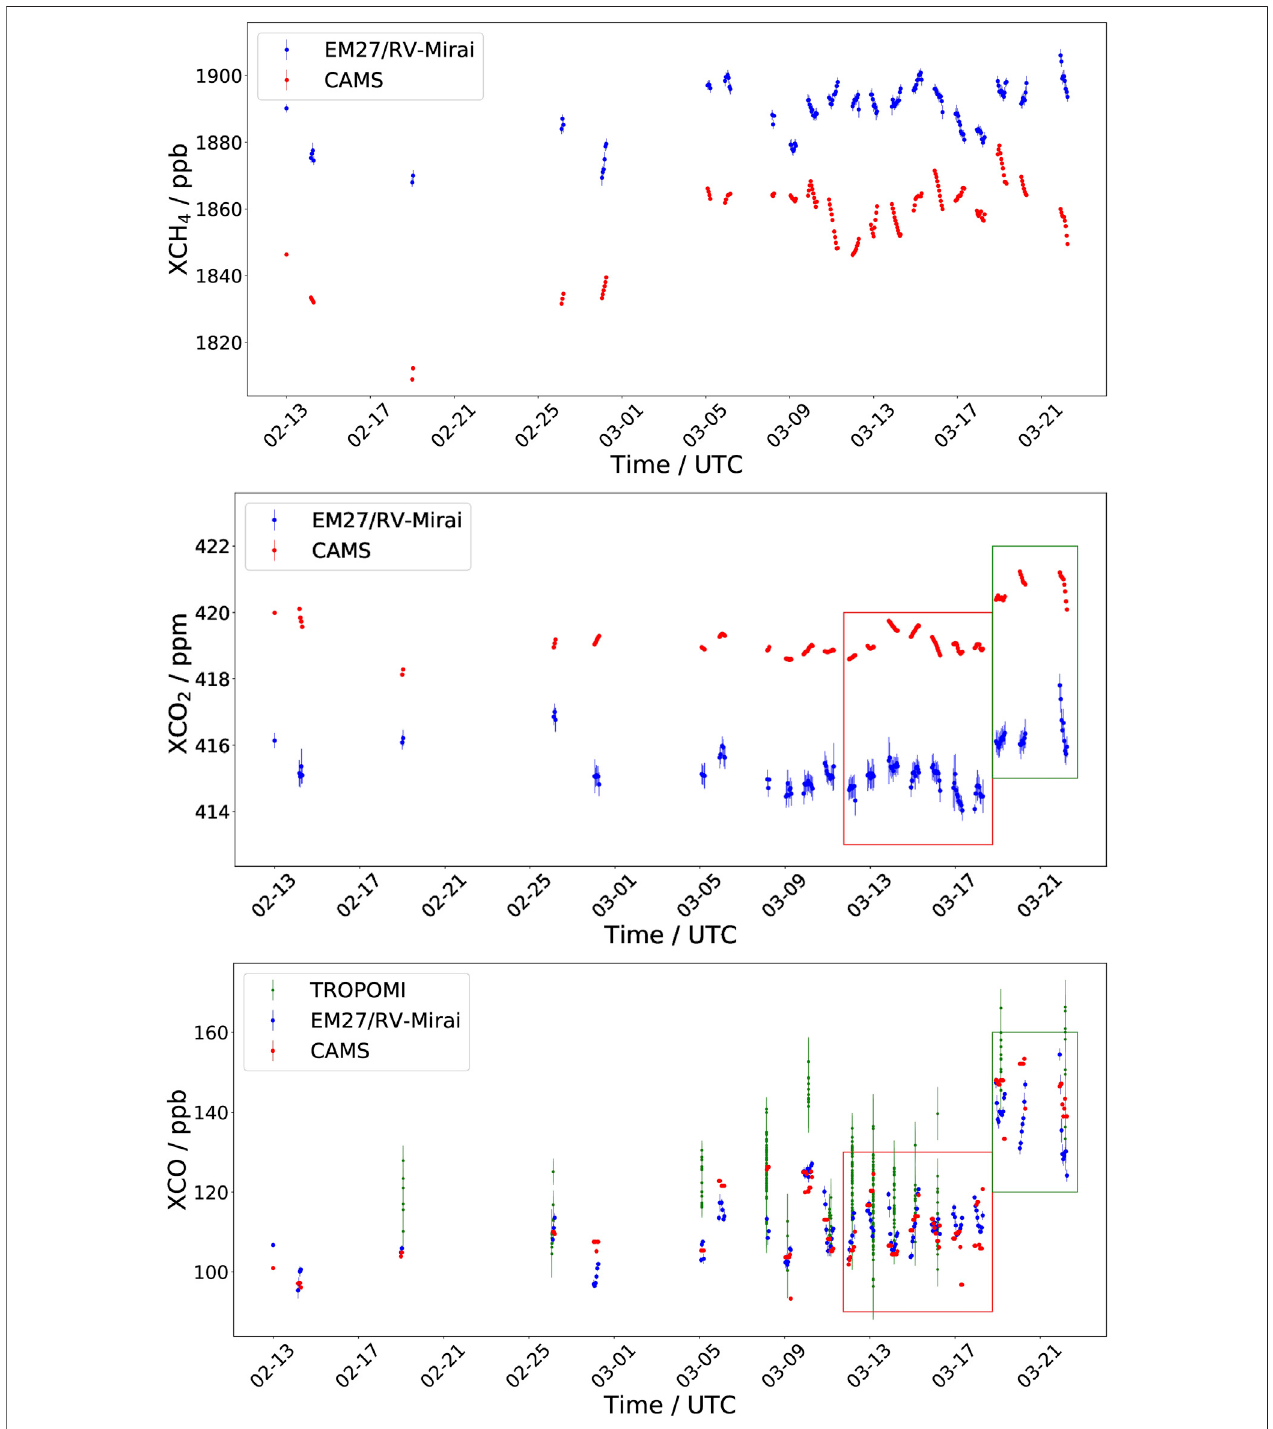
FIGURE4| TimeseriesofXCH 4 (upperpanel),XCO 2 (middlepanel),andXCO(lowerpanel)oftheEM27/SUNonRVMirai(blue),co-sampledCAMSdata(red),and co-incident TROPOMI XCO measurements (green). The EM27/SUN records our hourly averages with hourly standard deviations shown as error bars. For TROPOMI, individual XCO data are shown with their provided error-bars. The red and green boxes (upper and lower panel) de fi ne the background and enhancement periods, respectively, as discussed in Section 4 .